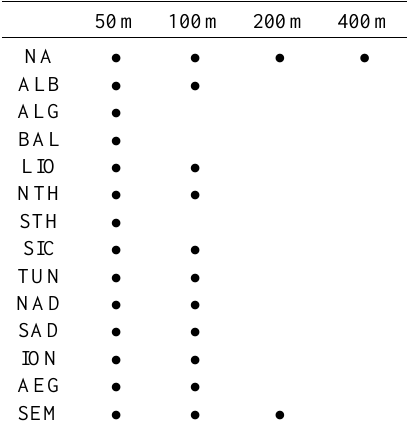
Table 2. Standard deviations from the annual mean higher than 1.5m/s at depths of 50, 100, 200 and 400m, for each